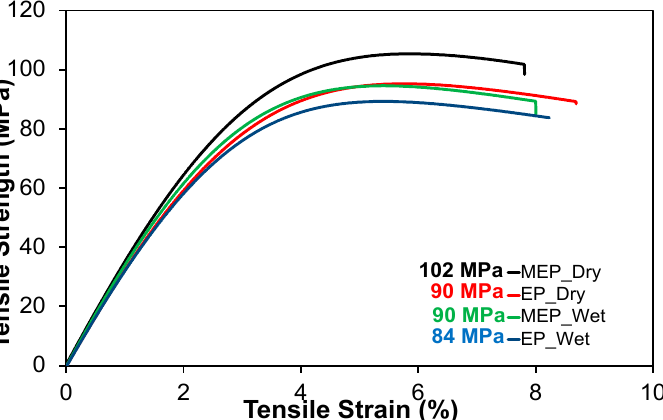
Figure 12. Representative stress–strain curves for anhydride-based reference (EP) and modified (MEP) epoxy systems. In dry and wet environments.